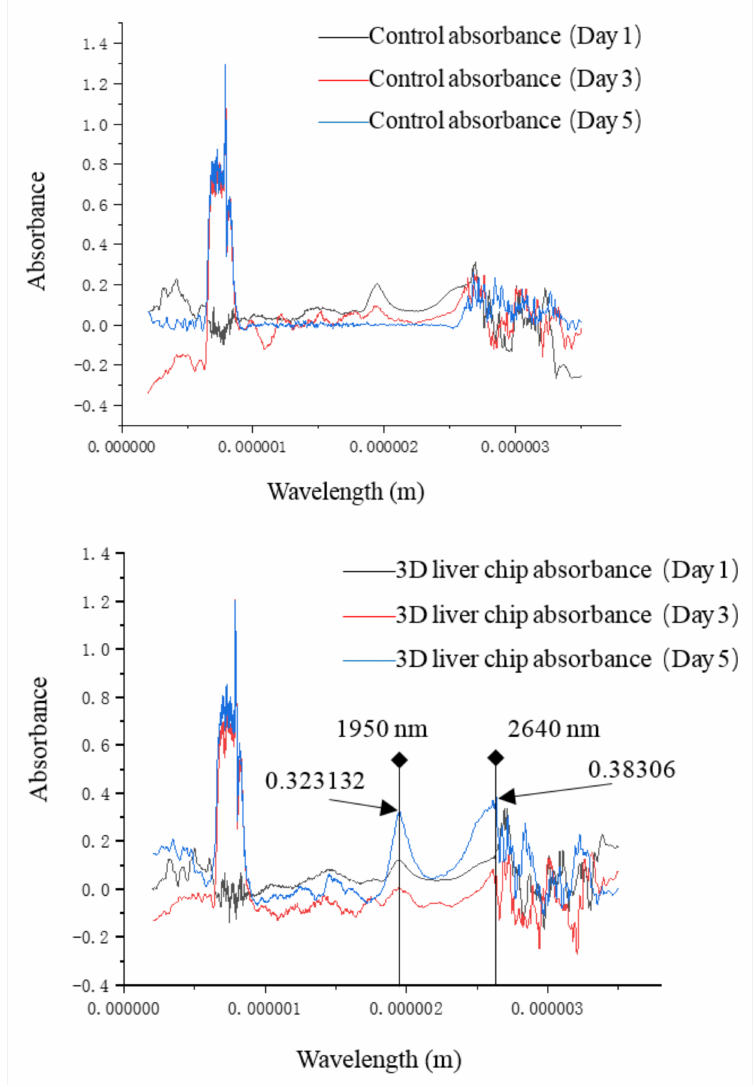
Figure 8. Results of